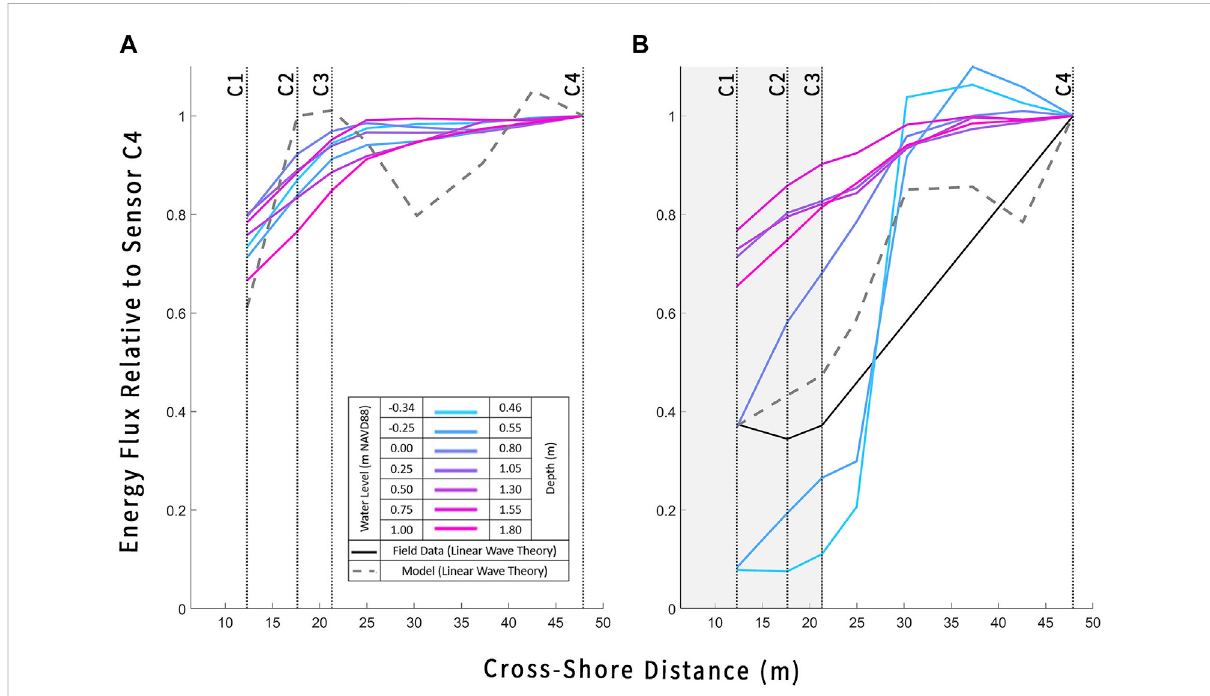
FIGURE 12 Modeled total energy fl ux normalized relative to C4 for simulations (A) with installation and (B) without installation. Dotted vertical lines denote labeled fi eld sensor locations. Shaded area delineates the installation